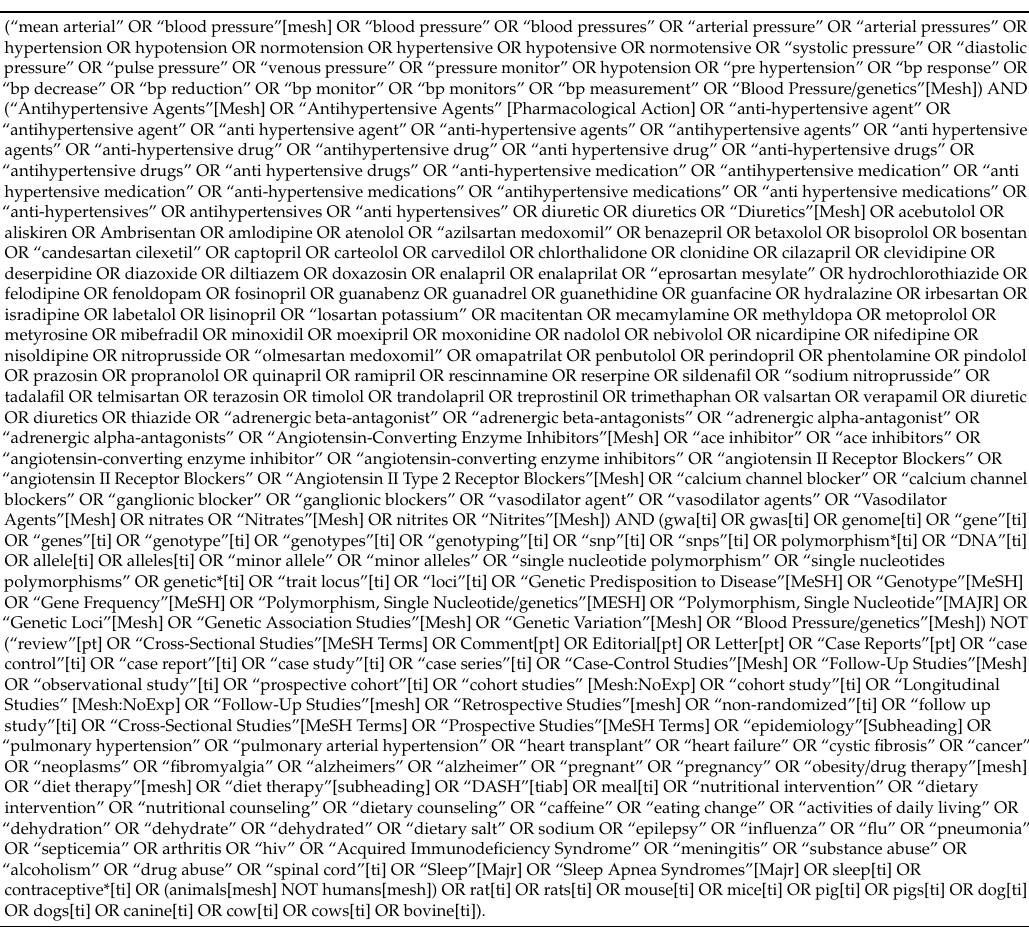
Table 3. Criteria 3. Genes (n = 28) in major blood pressure regulatory pathways associated with the blood pressure response to pharmacotherapy. The search was conducted on 05 / 11 / 2017 and a total of 711 records were